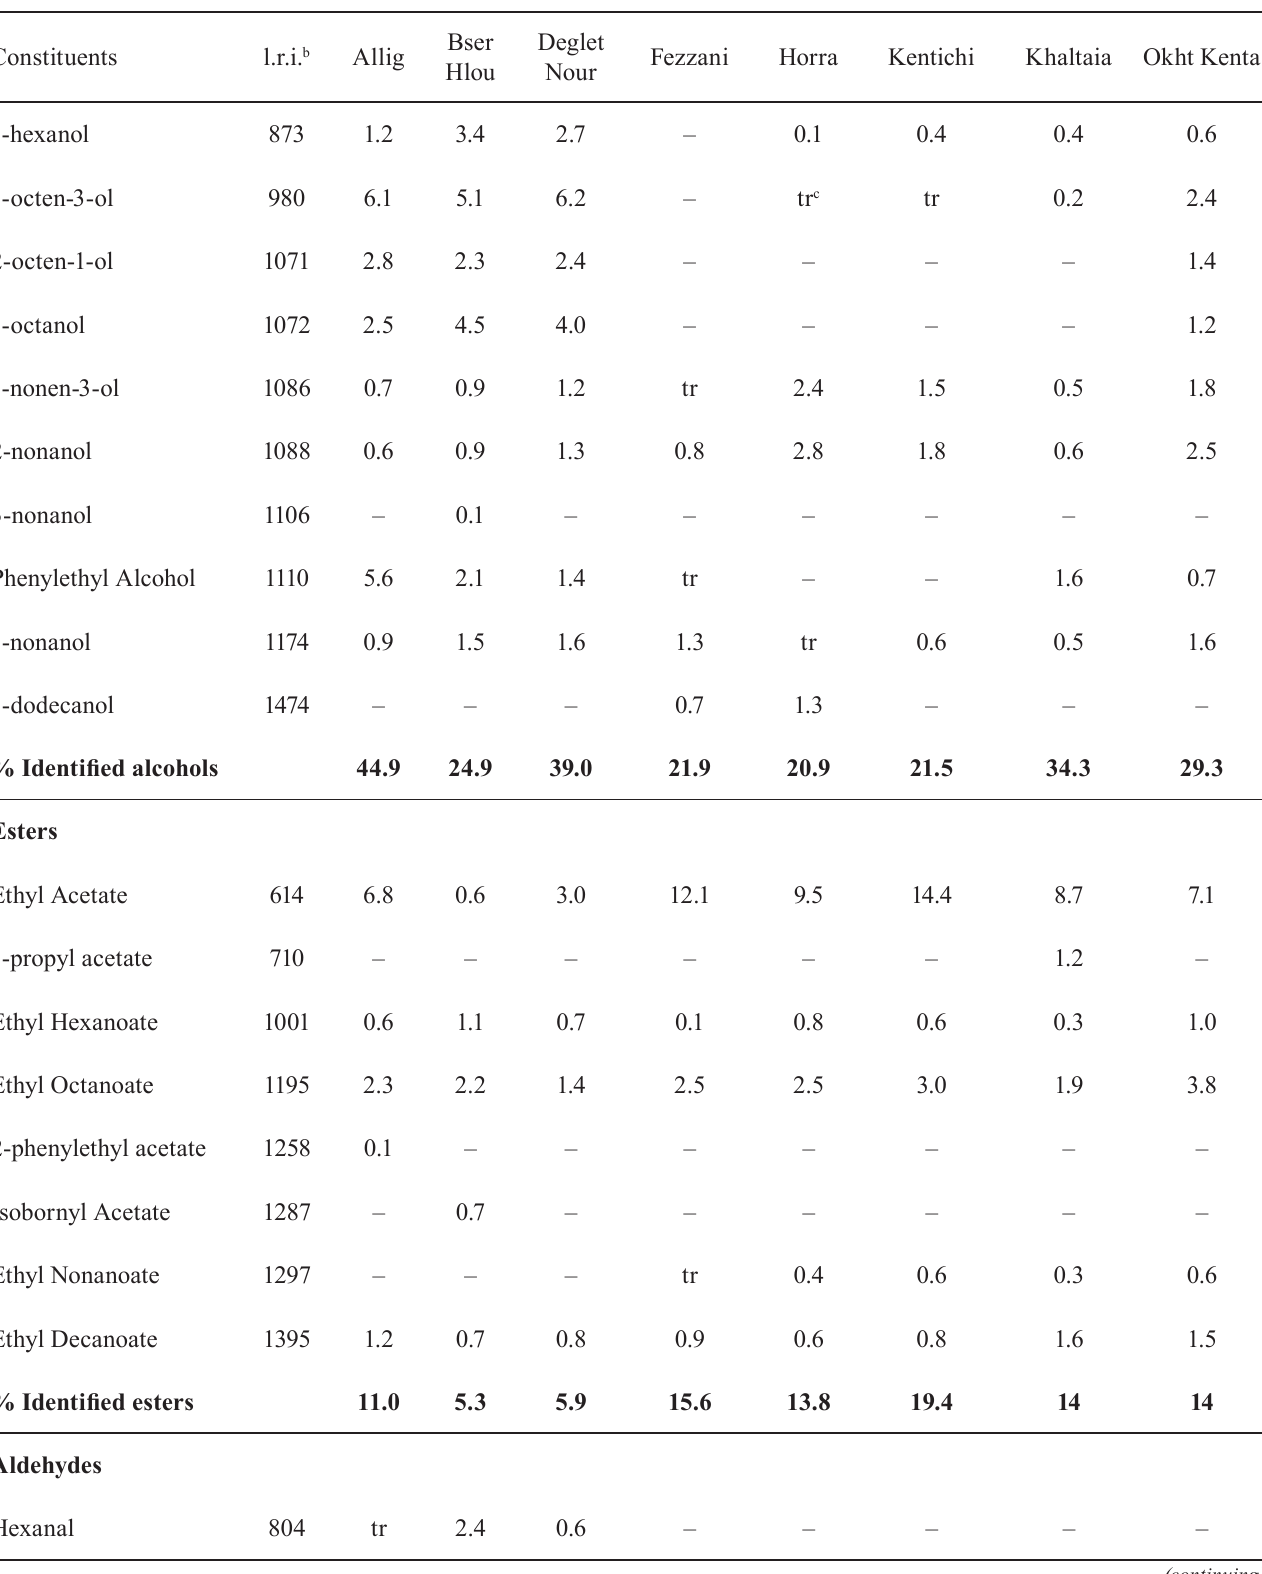
TABLE IV - Volatiles compositiona of date palm fruits obtained from eight varieties at Tamr stage (Cont.)